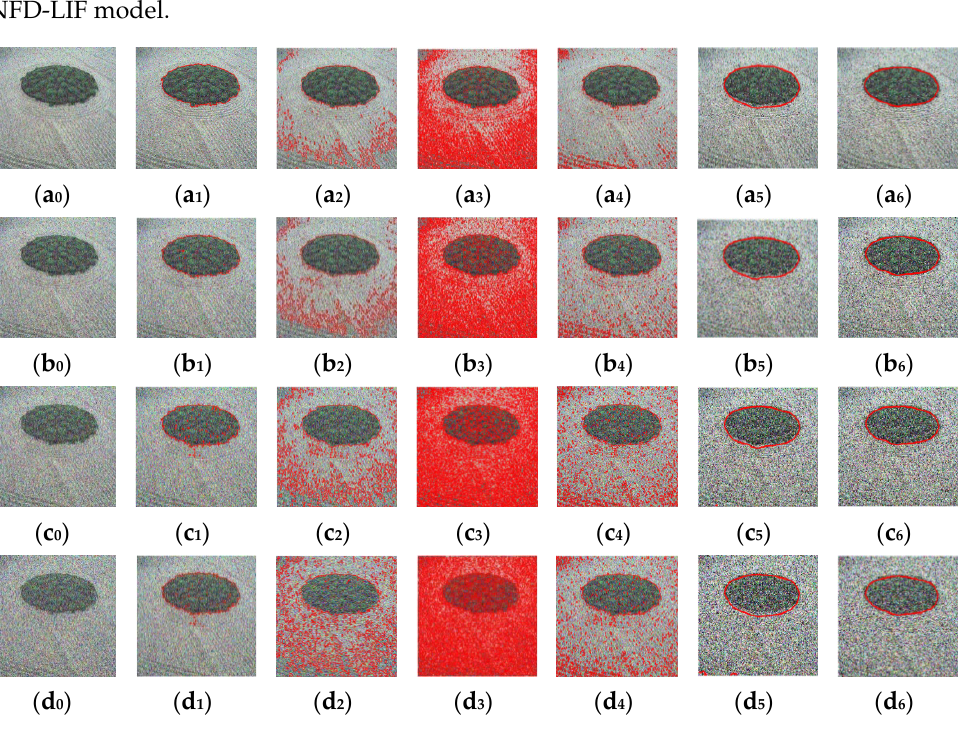
Figure 10. Image segmentation results for different pretzel noise levels: ( a 0 -d 0 ) are images with pretzel noise levels of 0.1, 0.2, 0.3, and 0.4, respectively. ( a 1 -d 1 ) are the LIC model segmentation results; ( a 2 -d 2 ) are the LIF model segmentation results. ( a 3 -d 3 ) are the ACM-LPF model segmentation results. ( a 4 -d 4 ) are the results of the LSACM model segmentation. ( a 5 -d 5 ) are the results of the segmentation using the model from [27]. ( a 6 -d 6 ) are the results of the NFD-LIF model segmentation.